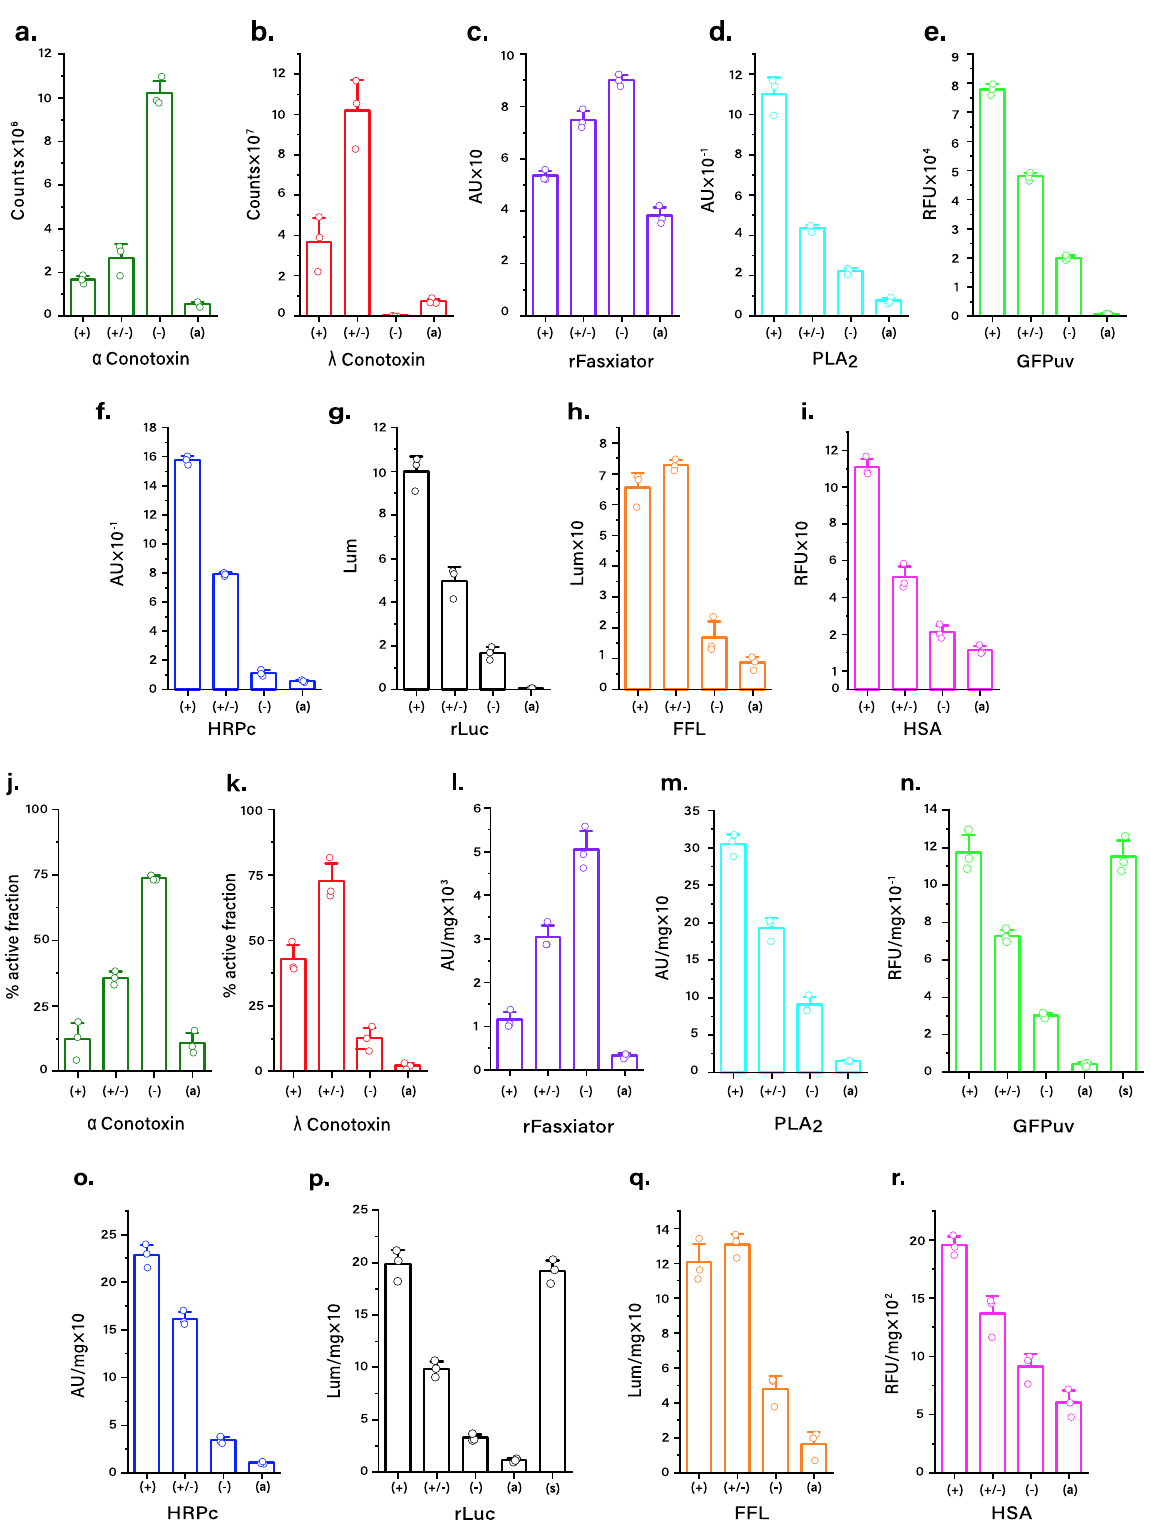
Fig. 2 Effect of tES – F116H on POI activity. a – i Activity assays of POI after folding with tES – F116H charge variants and in the absence of tES – F116H. j – r Speci fi c activity is increased with tES – F116H folding when compared with the respective POI-only folding. tES – F116H( + ), tES – F116H( + / – ), tES – F116H( – ) and POI alone are indicated as ( + ), ( + / – ), ( – ), and (a), respectively. GFPuv and rLuc could also be expressed as a soluble protein in the same expression; thus, POI puri fi ed from this soluble fraction is indicated as (s) and used as positive control. The molar ratio for each POI was 150:60 (Conotoxins), 15:60 (rFasxiator/PLA 2 ), 10:60 (HRP/GFP/rLuc), and 5:60 (HSA/FFL). (Data are presented as mean ± SEM., n = 3 independent experiments) (Source data are provided as a Source Data fi